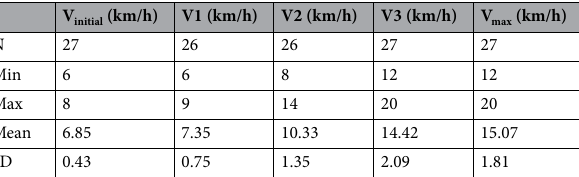
Table 2. Descriptive statistics of the running velocities at different experimental